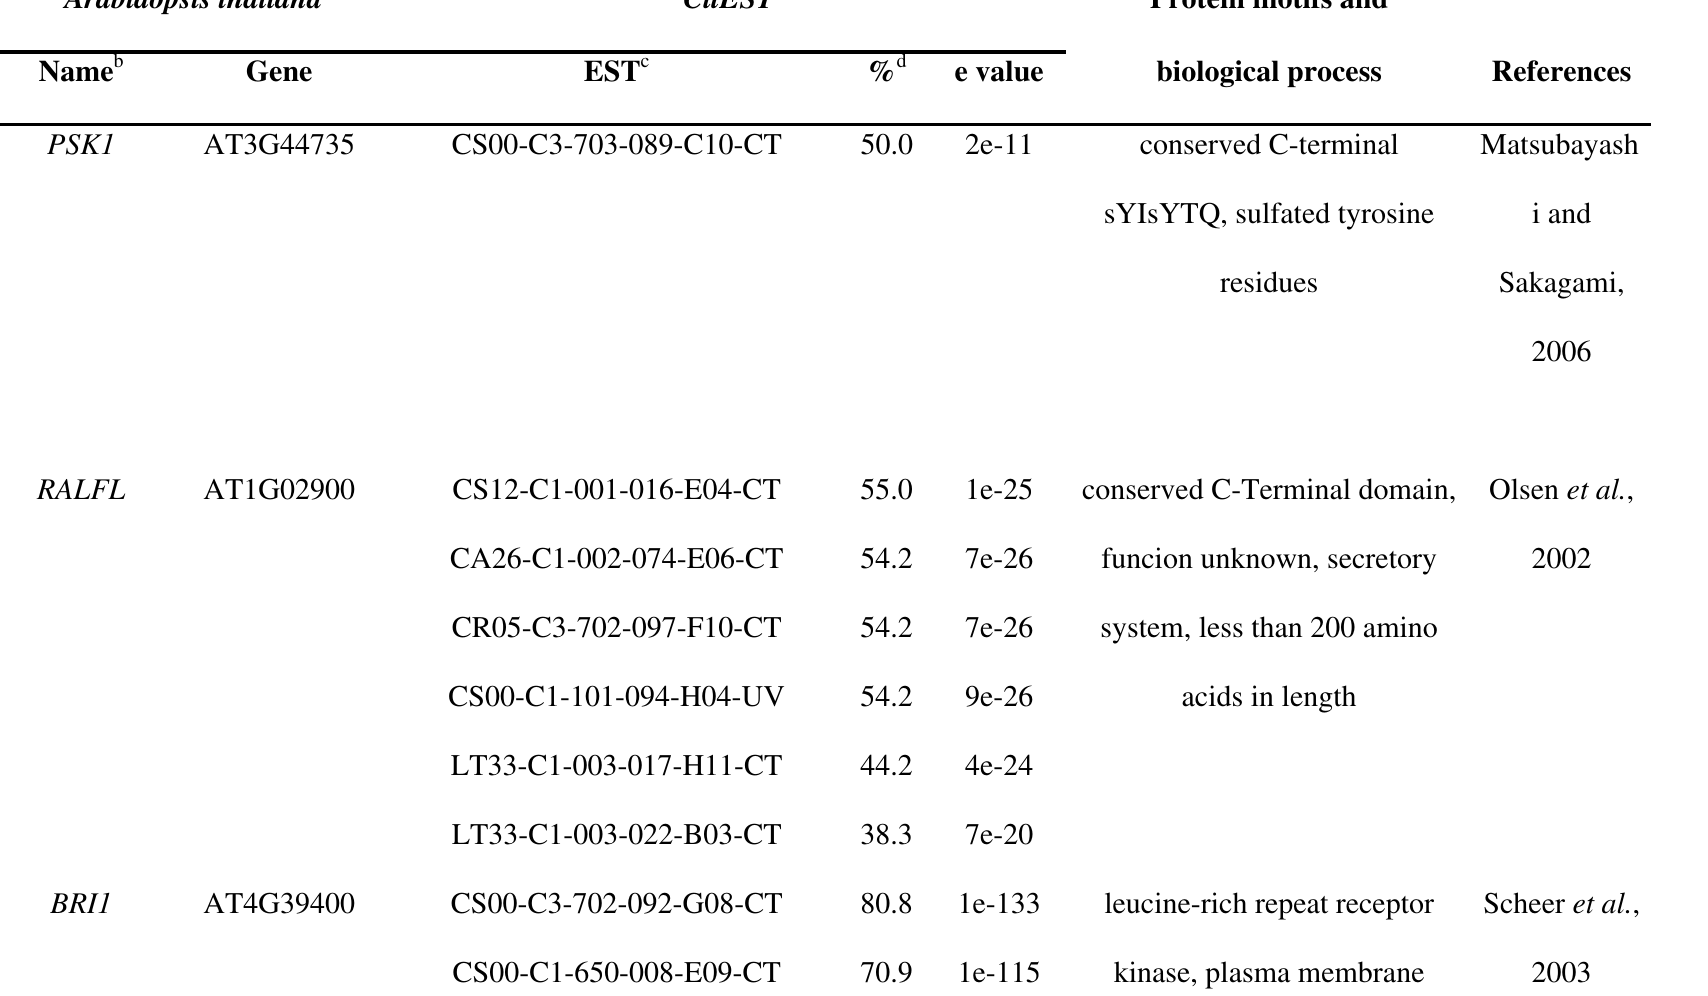
Table S13 – Citrus ESTs homologous to functionally-characterized plant peptide hormones a . Arabidopsis